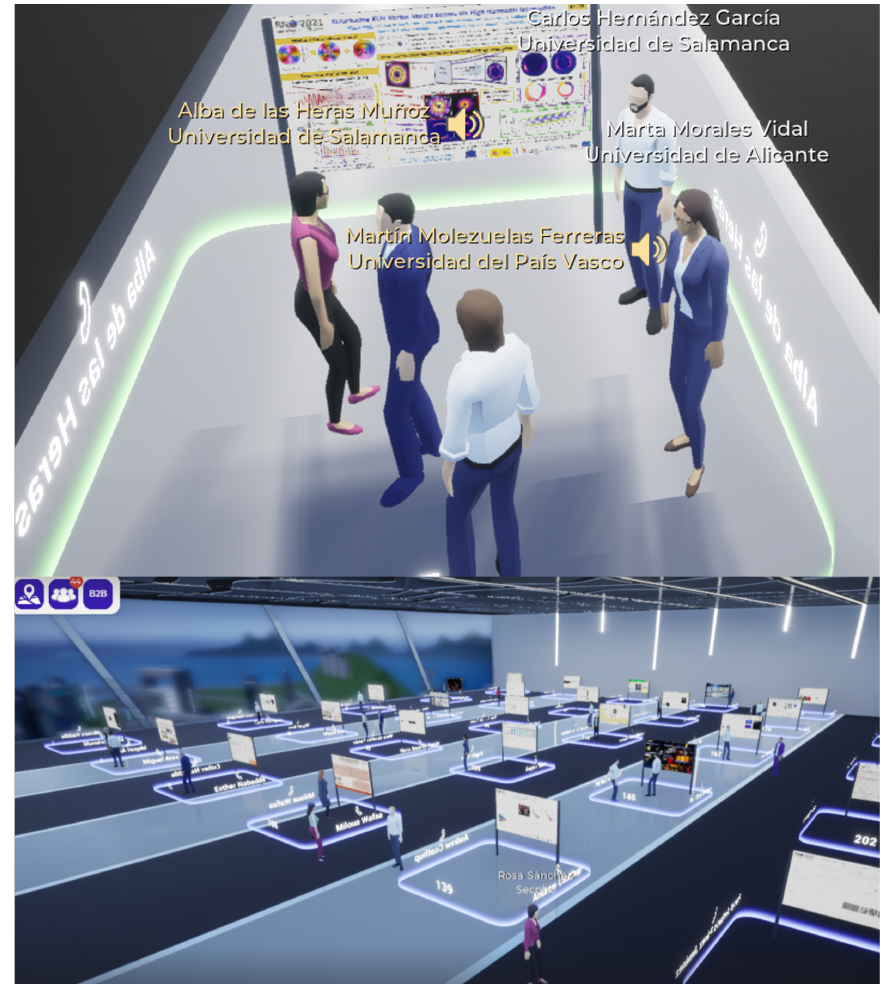
Figure 2. Snapshots of the Secpholand platform showing a poster